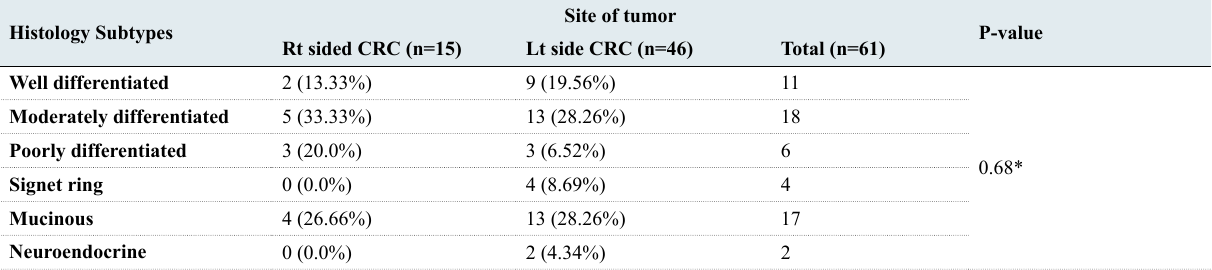
Table 2: Histology Subtypes of Adenocarcinoma as per the tumor location of CRC in the study population